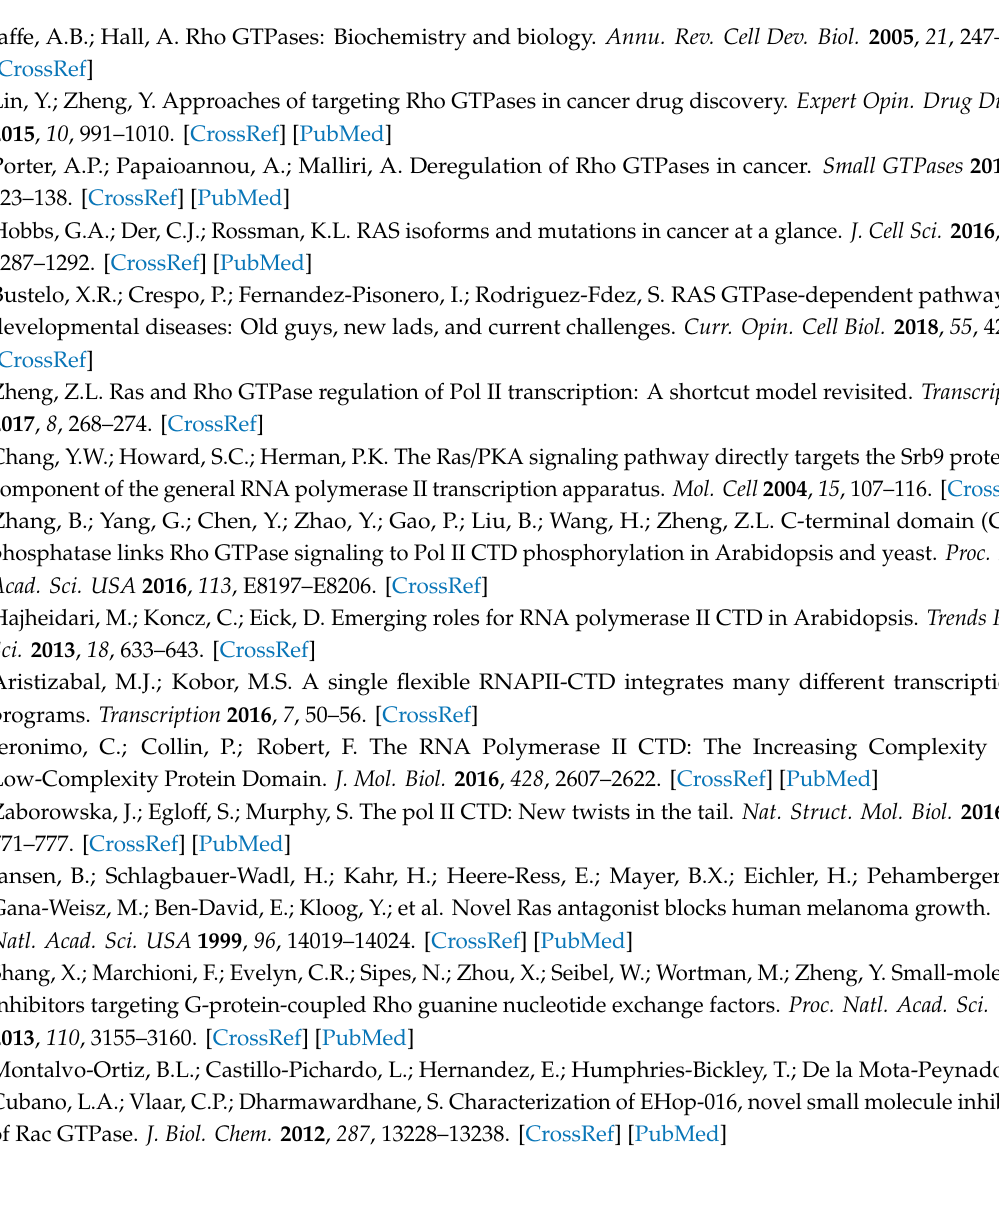
Figure S1. Quantitative analysis of cell number after Rac1 and Cdc42 siRNA treatments. Figure S2. Activation of ROP GTPase in the loss-of-function cae2-1 allele of the CTD Ser5 phosphatase-coding CPL1 gene in Arabidopsis plants. Figure S3. A dose response of Torin1 in enhancing the THZ1 e ff ect of decreasing cell number. Figure S4. The impact of THZ1 on CTD Ser2 / 5 / 7 phosphorylation, CDK7 / 13 and DOCK4 / 9 levels analyzed by the aggregated